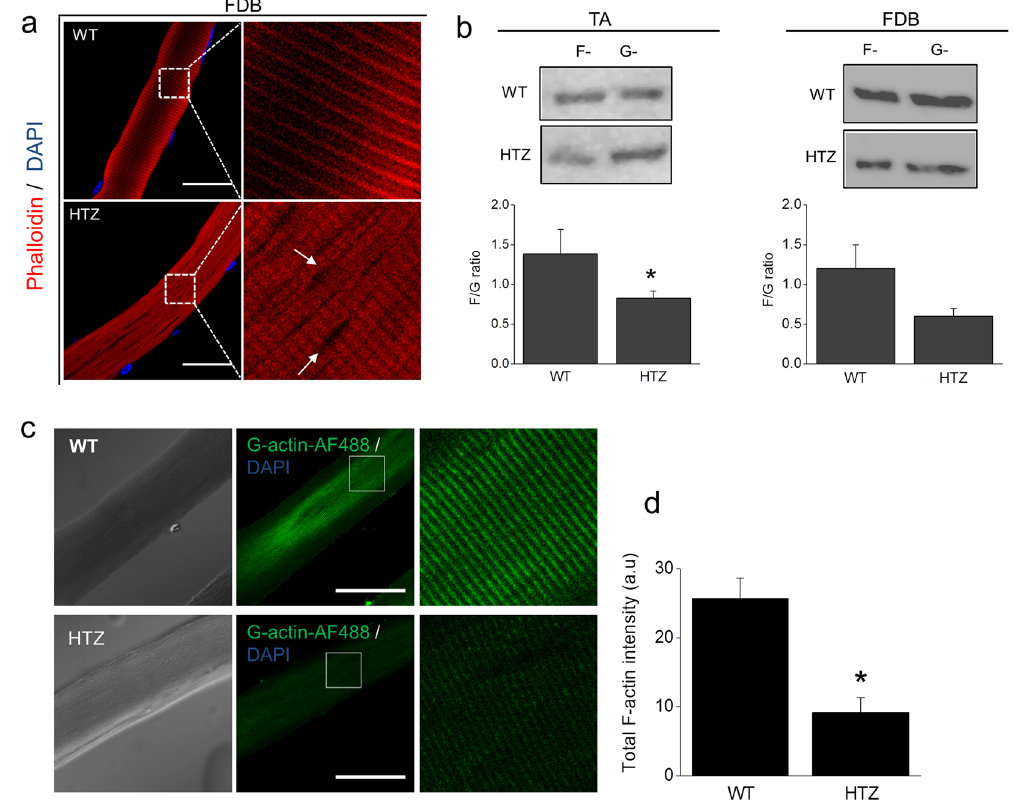
Figure 5. Actin organization and polymerization is altered in muscles of HTZ mice harboring the mutation R465W. ( a ) FDB muscles dissected from 2 month-old HTZ and WT mice were digested with collagenase. Fibers were isolated, fixed in PFA, permeabilized and stained with phalloidin-Rhodamine-B to visualize the actin network. Myonuclei were stained with DAPI. Representative confocal images of WT (top panels) and HTZ (bottom panels) fibers are shown. White square enclose the enlarged areas. Notice that phalloidin-staining looks altered in HTZ myofibers, exhibiting non-stained areas that did not localize with DAPI-stained nuclei (white arrows). Scale bar = 20 µ m; n is between 48 and 50 fibers from eight different animals per genotype. ( b ) To evaluate the relative amounts of F- and G-actin, freshly dissected tibialis anterior (TA, left) and FDB muscles (right) were lysed with a commercial F/G actin in vivo assay, electrophorated by 12%-SDS-PAGE and revealed by western blot using a polyclonal actin antibody. Above are shown representative blots for F- and G-actin per muscle and genotype; these are cropped images and the original full-length blot is shown in Supplementary Fig. S2. Below are plotted the F/G actin ratios per genotype. Note that F/G tend to be lower in HTZ muscles compared to WT muscles in both TA and FDB, although this difference is only significant in TA muscles. Data are expressed as the mean F/G ratio ± SEM for muscles from at least three animals per genotype. Statistical comparisons were performed utilizing a two-tail Mann-Whitney non-parametric test. * denote significance with respect to WT-muscles. ( c , d ) To evaluate actin polymerization, isolated FDB myofibers were stimulated with 0.1 µ M insulin during 10 min at 37 °C, permeabilized with digitonin in the presence of G-actin-AF488, fixed and visualized by confocal microscopy. ( c ) Representative images of newly formed actin filaments in WT and HTZ fibers. Left panels show the respective DIC images. Scale bar = 20 µ m. ( d ) Quantification of total G-actin-AF488 fluorescence intensity. Note that HTZ fibers exhibit a decreased capability to form new actin filaments compared to WT fibers. Data are expressed as mean actin signal ± SEM. Statistical comparisons were performed utilizing a two-tail Mann-Whitney non-parametric test. The symbol * denote significance with respect to WT-fibers. N is between 24 and 25 fibers from five different animals per